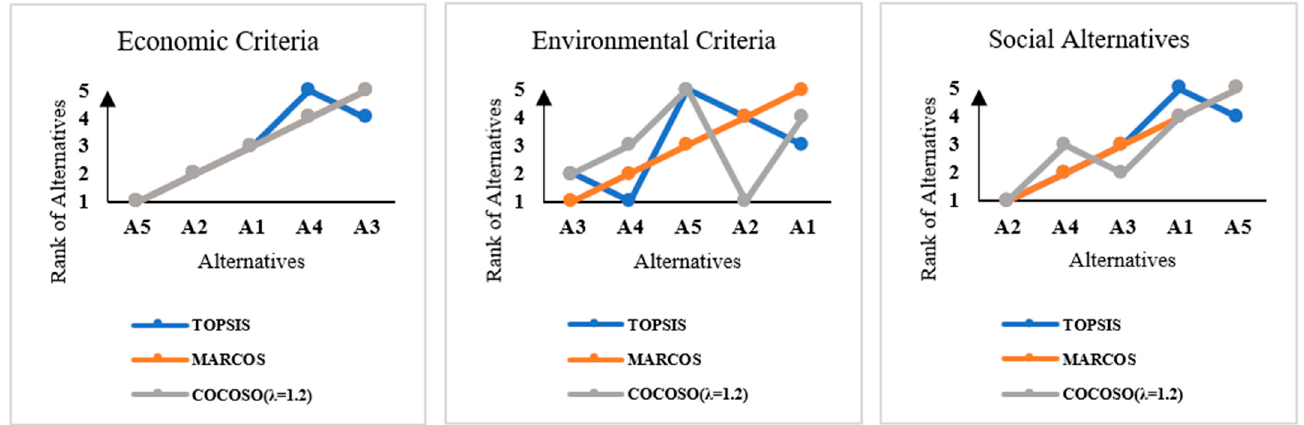
Figure 6. Comparison of the applied methods with each other.